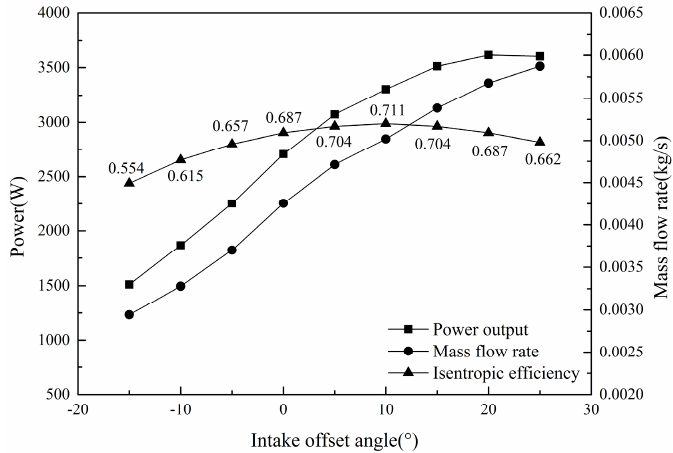
Figure 13. Effects of intake offset angle on the expander performance.